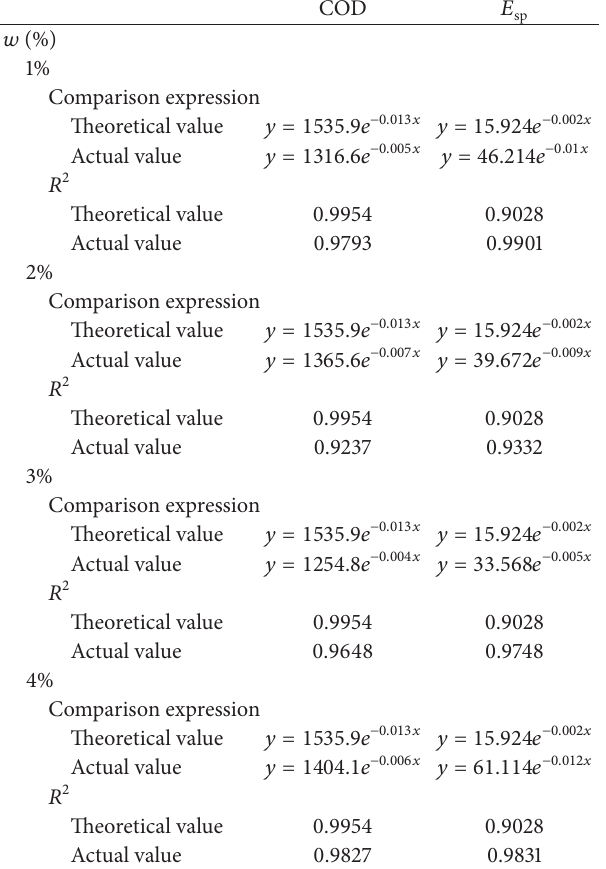
Table3:Relationandrelatedcoefficienttreatingdifferentelectrolyte concentration phenol